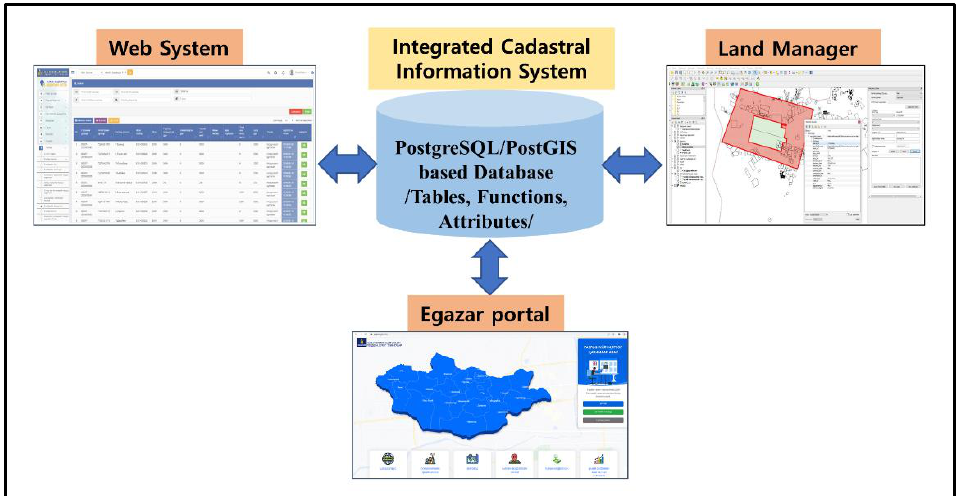
Figure 3. Overview of Land Manager program. Adopted from [31].